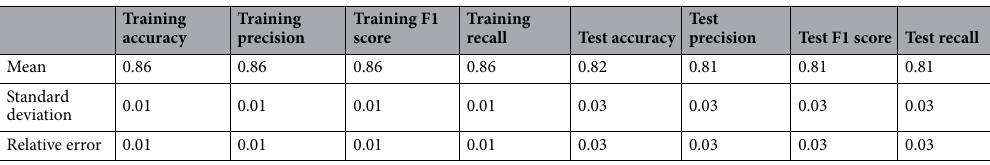
Table 1. Cross-validated developed models performances.